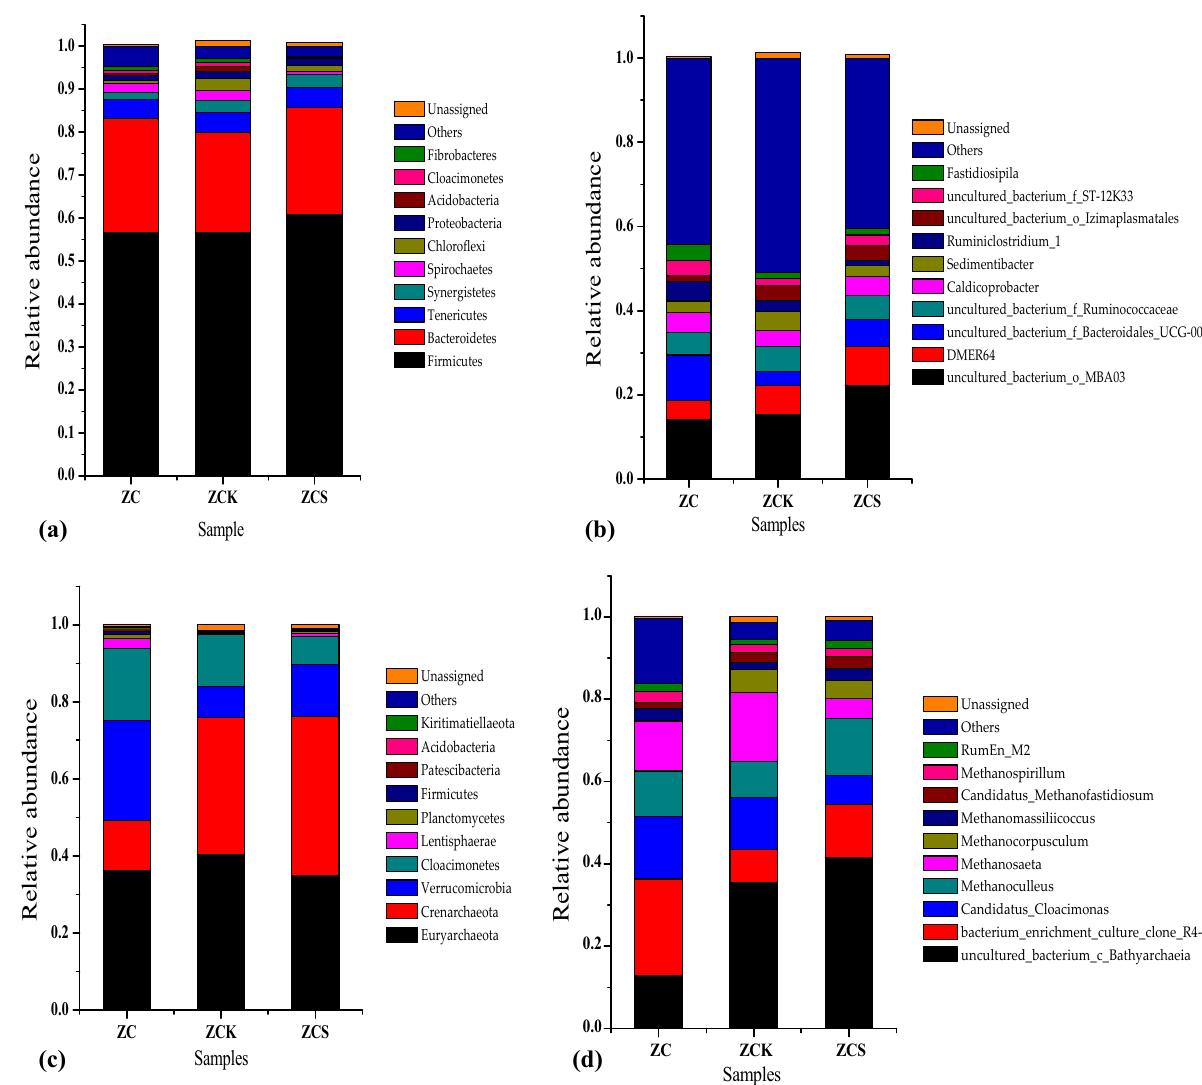
Figure 5. Flora species analysis ( a ) Phyla analysis of bacterial flora species; ( b ) Genera analysis of bacterial flora species; ( c ) Phyla analysis of archaea flora species; ( d ) Genera analysis of archaea flora